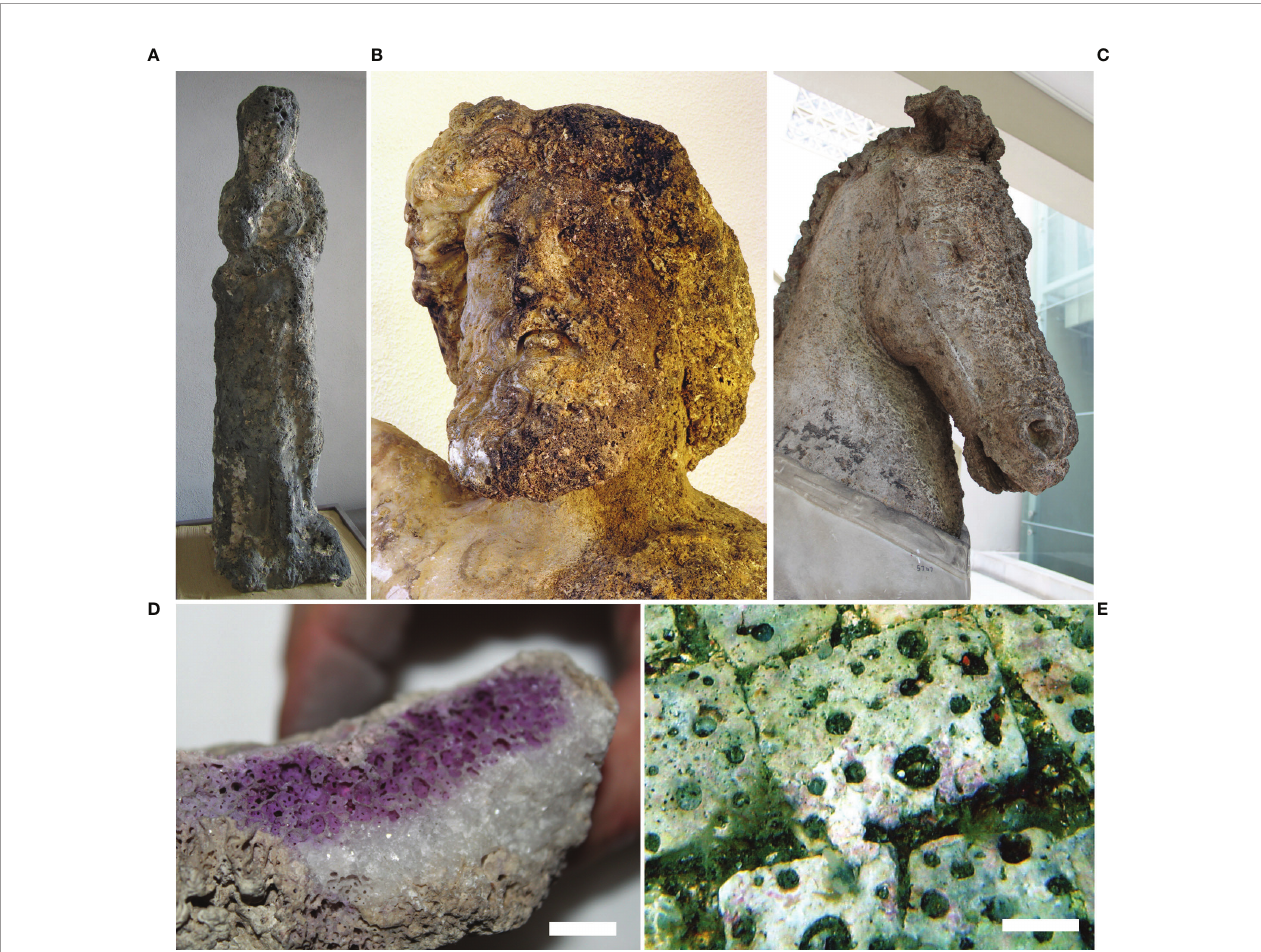
FIGURE 5 | Sponges. (A) Statue of the Pudicitia type from submerged Baiae (Archaeological Museum of Campi Flegrei); (B) head of the statue of Poseidon from the Grotta Azzurra (Casa Rossa, Anacapri); (C) horse statue from the Antikythera shipwreck (National Archaeological Museum of Athens); (D) boring chambers produced by the species Cliona schmidtii in marble statue fragment; this species is characterized by a purple color which persisted in the samples (macro photo, scale bar: 1 cm); (E) mosaic tesserae of the submerged fl oor of the Villa dei Pisoni in the Underwater Archaeological Park of Baiae excavated by C . celata (underwater photo). Scale bars: (D) = 1 cm; (E) = 0.5